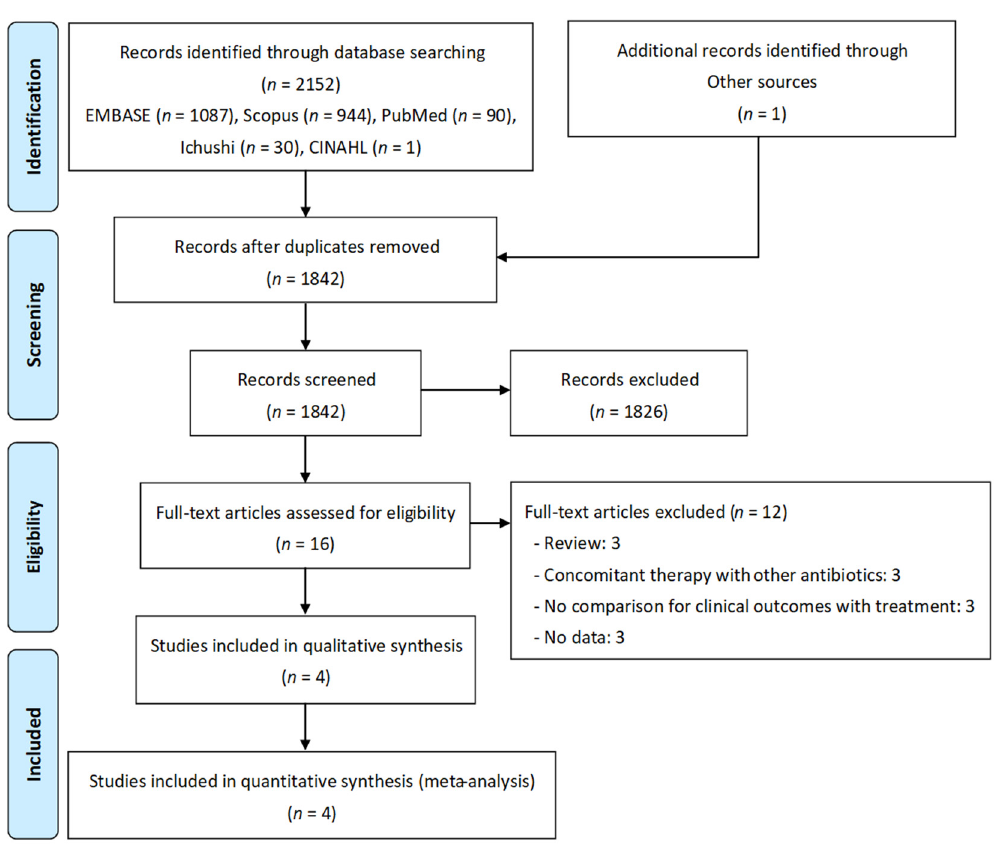
Figure 1. PRISMA flow diagram of the study selection process.